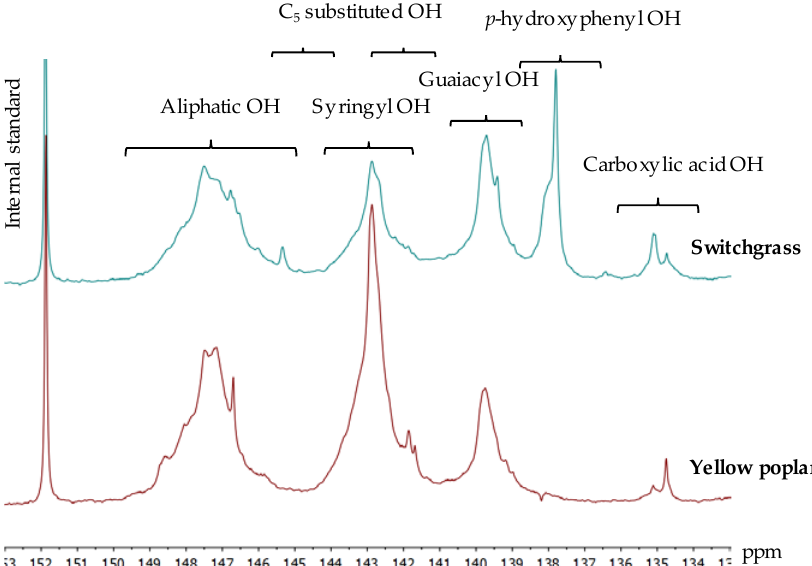
Figure 1. Quantitative 31 P NMR spectra and signal assignment of lignin samples.